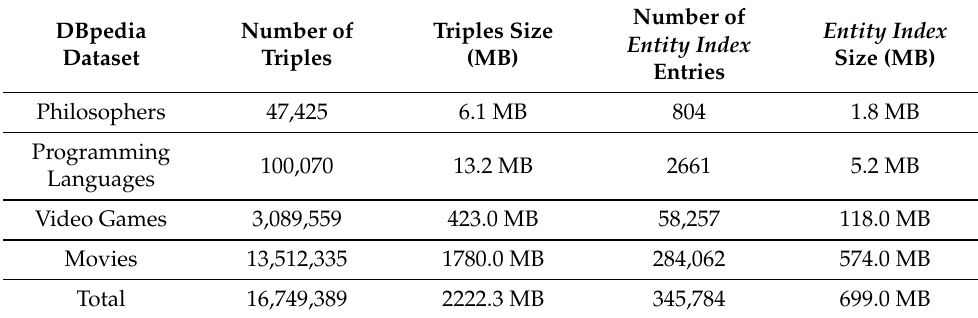
Table 2. Datasets supported by RDFsim .